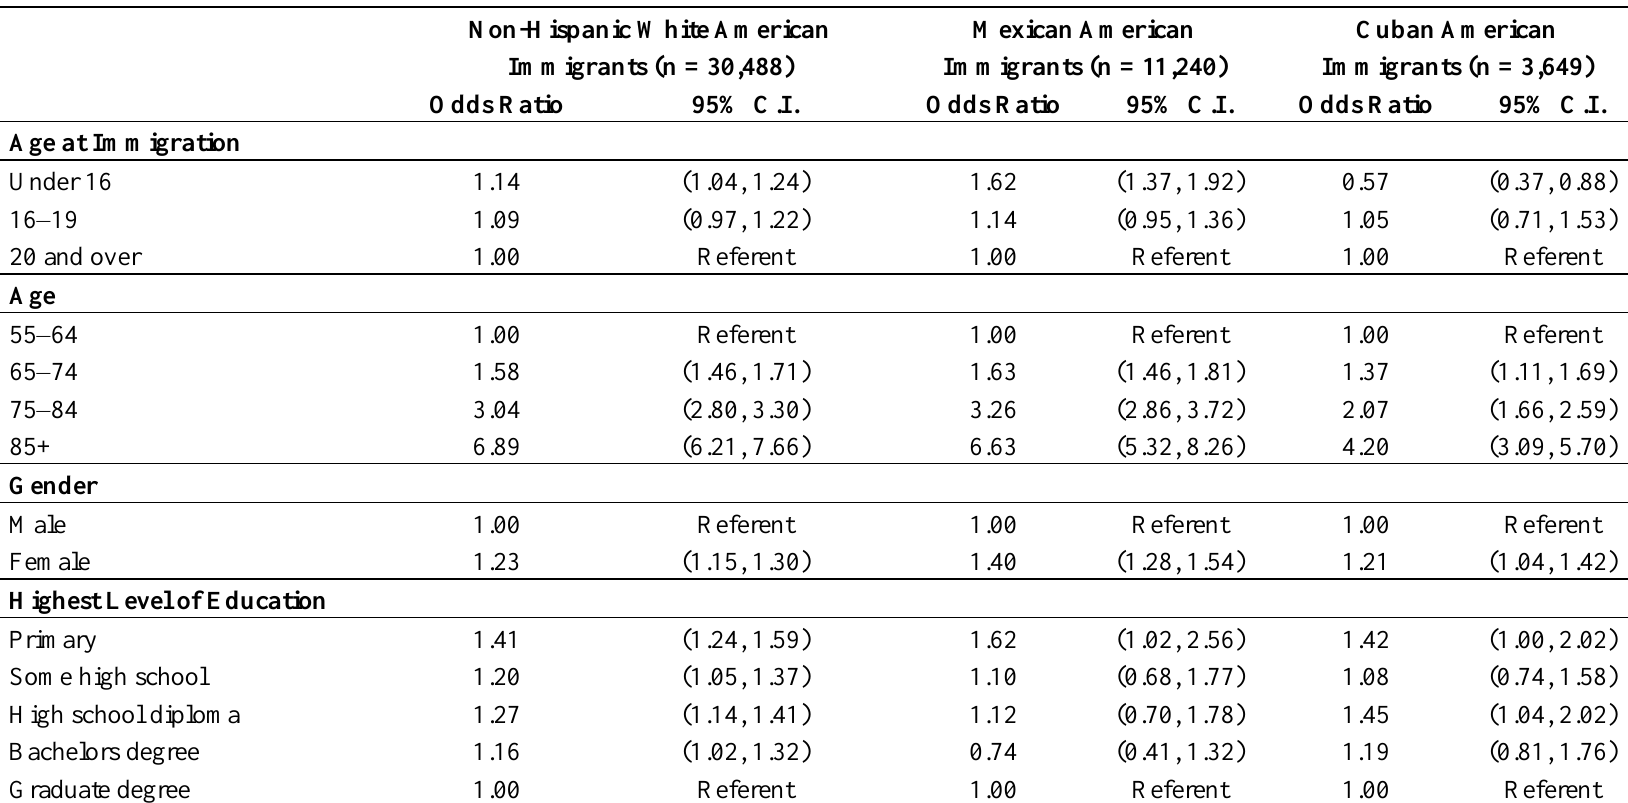
Table 7. Logistic regression analyses of functional limitations status by age at immigration for non-Hispanic White American immigrants, Mexican American immigrants and Cuban American Immigrants controlling for socio-demographic characteristics, English skills & citizenship